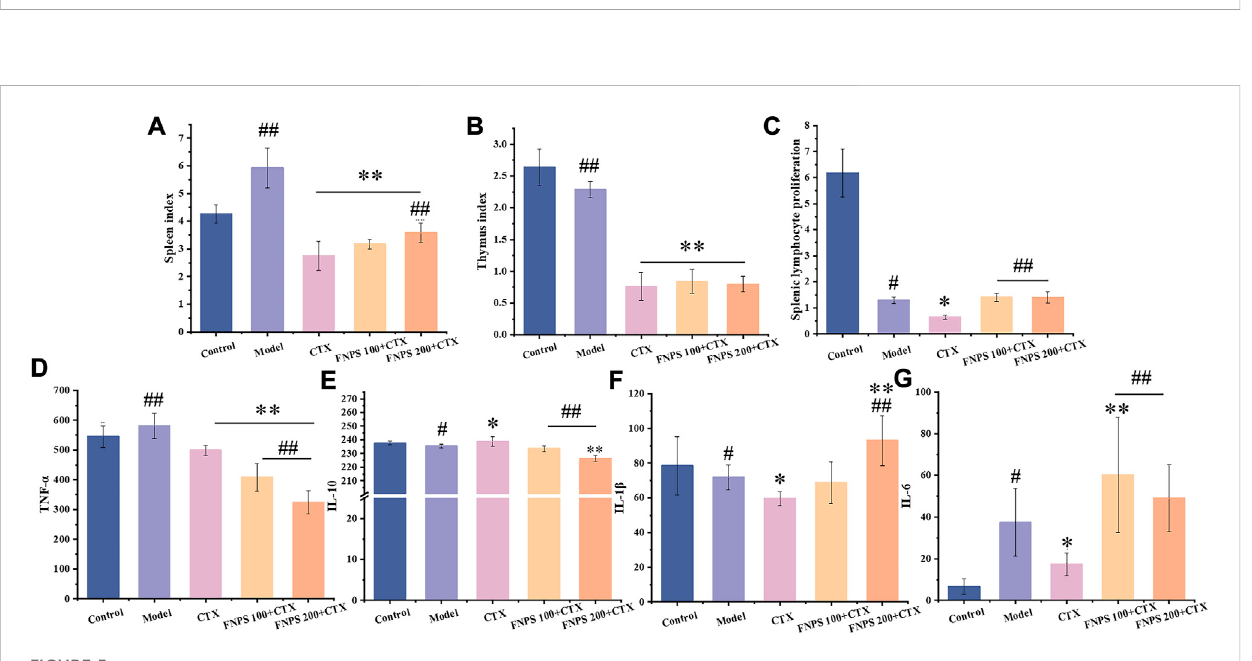
FIGURE 5 EffectsofFNPSonH22tumor-bearingmicetreatedwithchemotherapy. (A) EffectsofFNPSonspleenindex. (B) EffectsofFNPSonthymusindex. (C) FNPS reduces the inhibitory effect of chemotherapy on lymphocyte proliferation. (D) TNF- α levels in the serum. (E) IL-10 levels in the serum. (F) IL-1 β levelsintheserum. (G) IL-6levelsintheserum.Note:Control,normalmice;Model,untreatedtumormodelmice;CTX,cyclophosphamidetreatedtumor model mice; * p < 0.05 versus Model, ** p < 0.01 versus Model, # p < 0.05 versus CTX, ## p < 0.01 versus